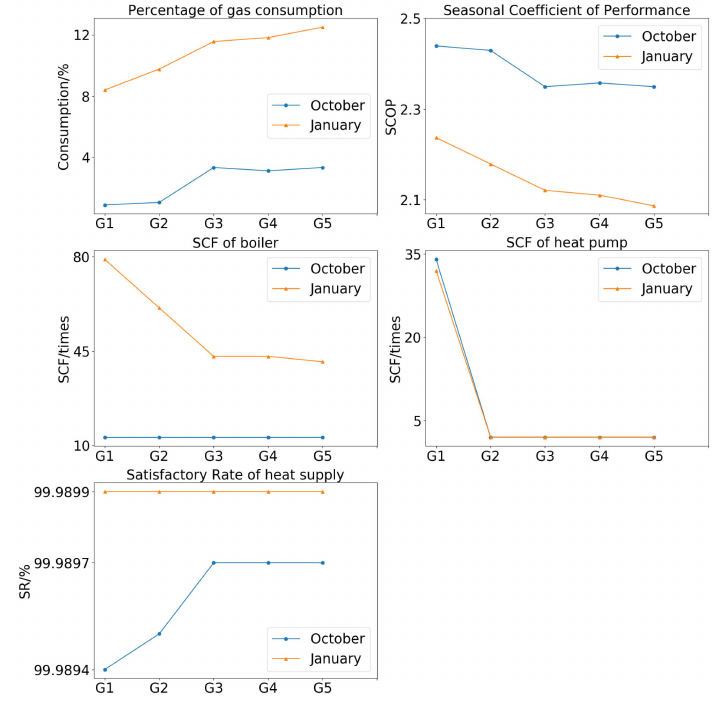
Figure 15. The key performance indicators of the simulation groups in the winter and the transition season with the charge state of the heat storage as the transition condition. SCF: signal-changing frequency, frequency of mode changing during the simulation; SCOP: seasonal coefficient of perfor- mance; SR: satisfaction rate in %, percentage of time that demands are satisfied. Table 4. The weights of the KPIs applied to evaluate the mode-based control strategy. SR: Satisfac- tory rate; PNR: Percentage of non-renewable energy consumption; SCOP: Seasonal Coefficient of Performance; SCF B , SCF HP : Signal-changing frequency of the boiler and the heat pump. KPI w SR w PNR w SCOP w SCF_B w SCF_HP Weight 1 − 1 − 0.01 − 0.01